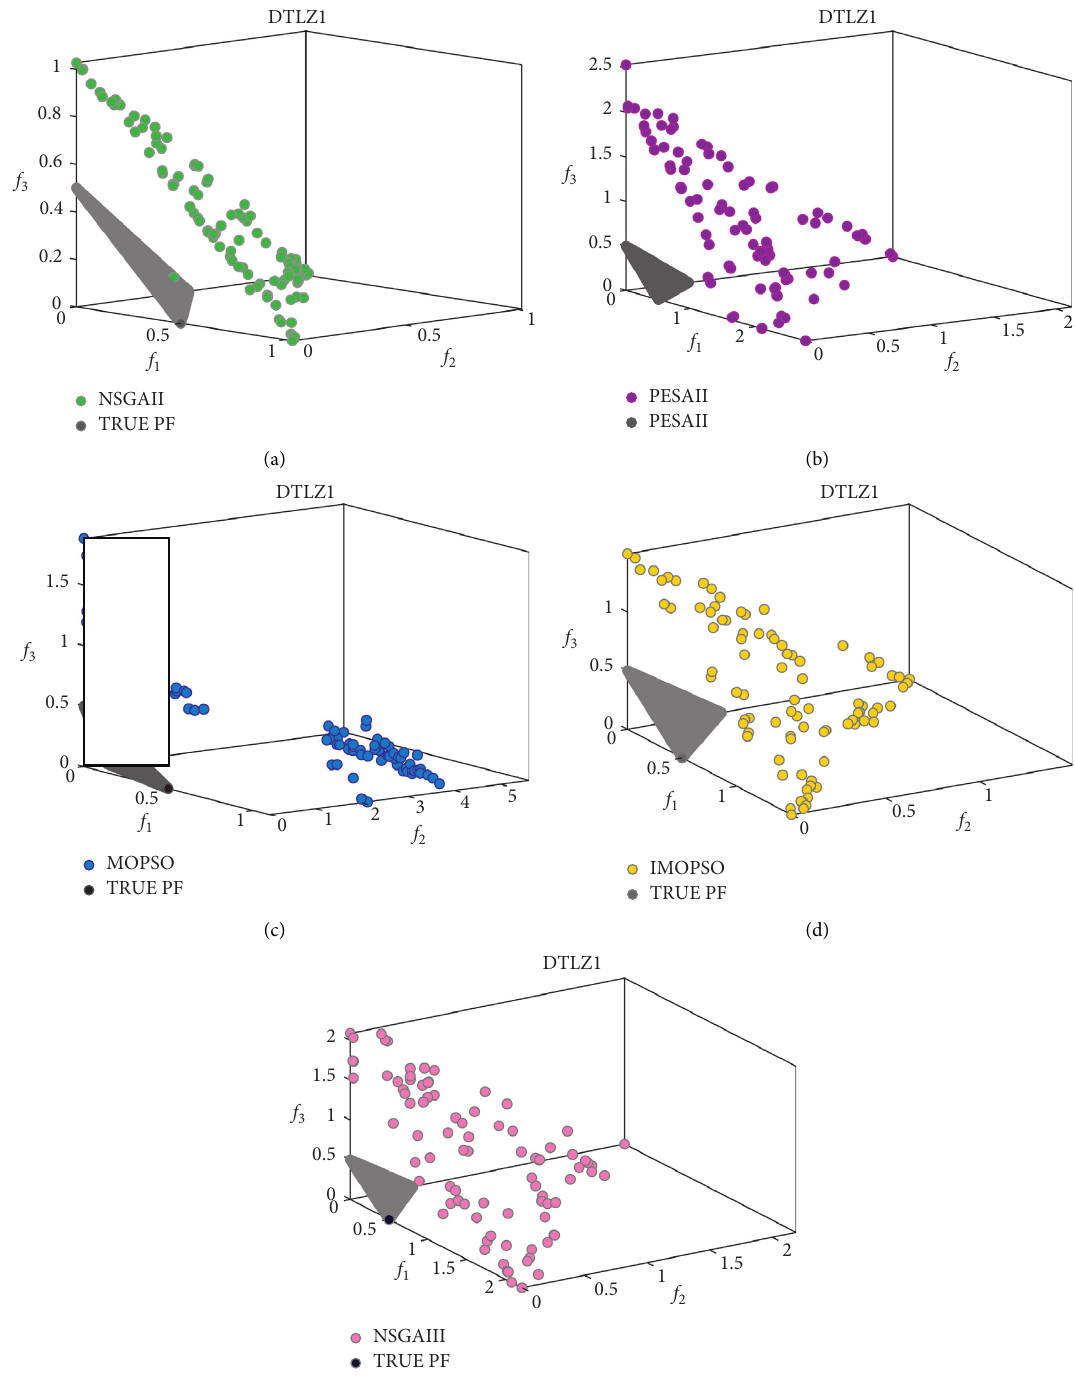
Figure 7: DTLZ1 test